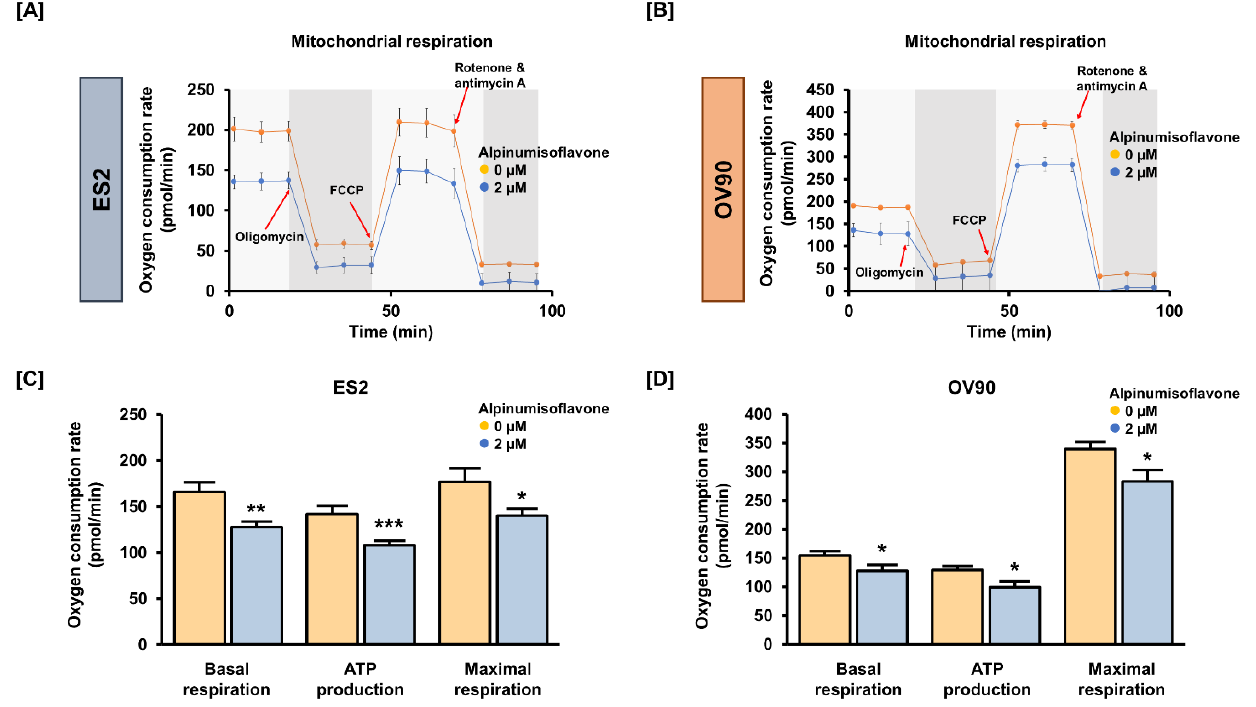
Figure 4. In ES2 and OV90 cells, alpinumisoflavone regulates mitochondrial energy metabolism. ( A , B ) The Seahorse Mito Stress test was adopted to examine the OCR of ES2 and OV90 cells after alpinumisoflavone (2 μM) treatment. Oligomycin (1.5 μM), FCCP (0.5 μM) and rotenone/antimycin A (0.5 μM) were serially administered. ( C , D ) Bar graphs indicate data from the Seahorse analysis for basal respiration, ATP production and maximal respiration. The control ES2 and OV90 cells are represented by orange-colored lines or bar graphs, while the alpinumisoflavone-treated ES2 and OV90 cells are represented by blue-colored lines or bar graphs. The level of significance between the vehicle and treatment groups is depicted by asterisks (* p < 0.05, ** p < 0.01 and *** p < 0.001).